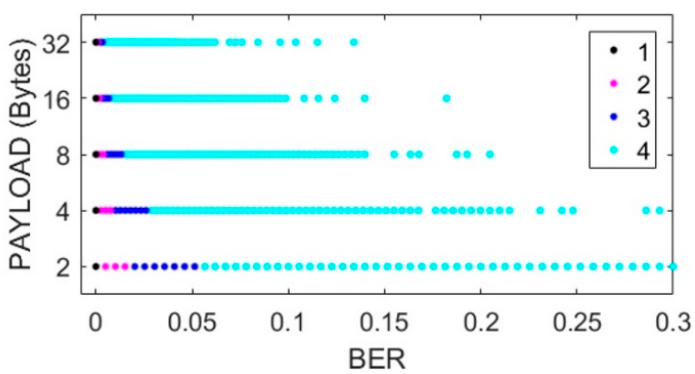
Figure 5. Scatterplot of payload against